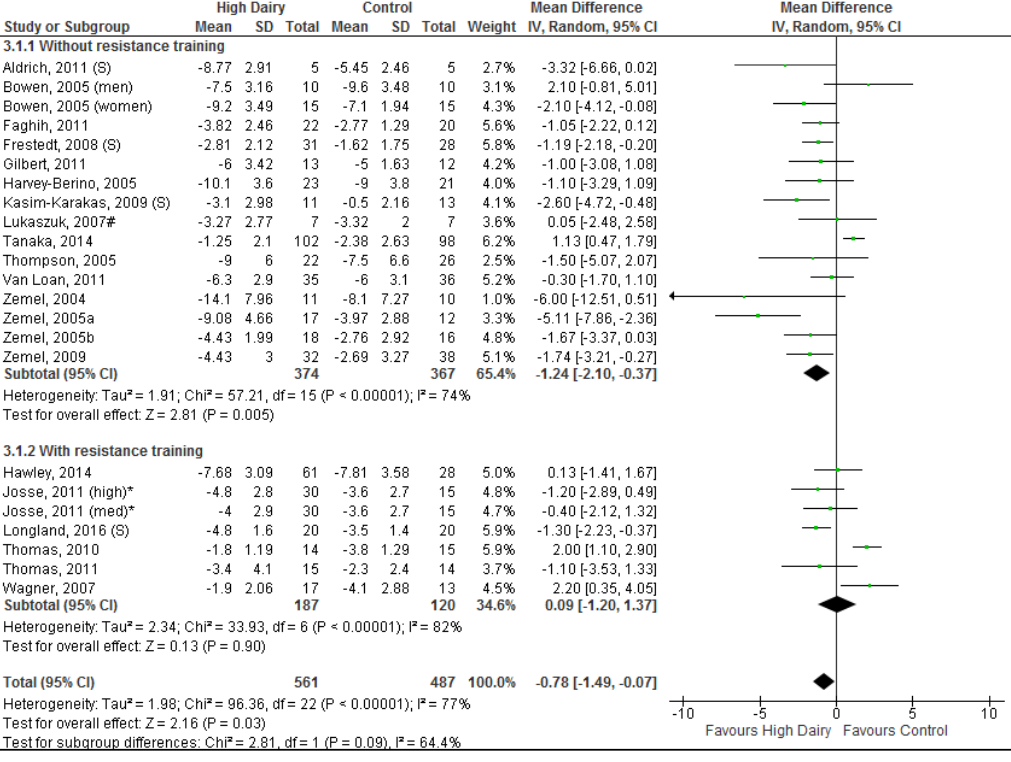
Figure 3. Forrest plot of mean (95% CI) weighted differences in body fat mass (kg) between high dairy and control groups stratified for sub-groups with resistance training vs. without resistance training. Results when Tanaka, 2014 excluded: − 1.41 kg [ − 2.04, − 0.77 kg], Z = 4.86 ( p < 0.001); Heterogeneity: Chi 2 = 22.61, df = 15 ( p = 0.09). (S) The intervention was dairy supplements; # The comparison group